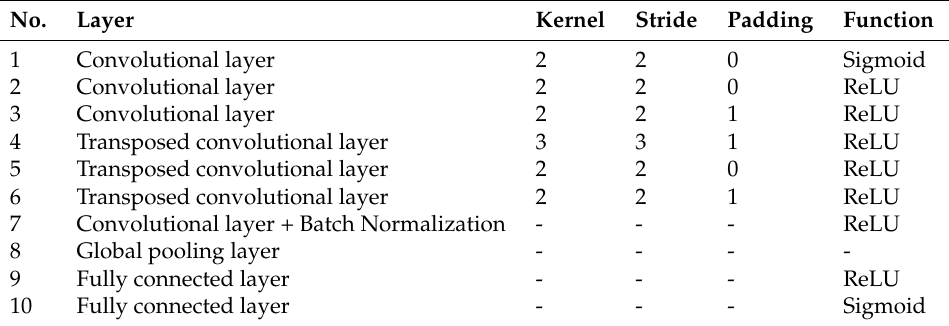
Table 2. The hyperparameters of